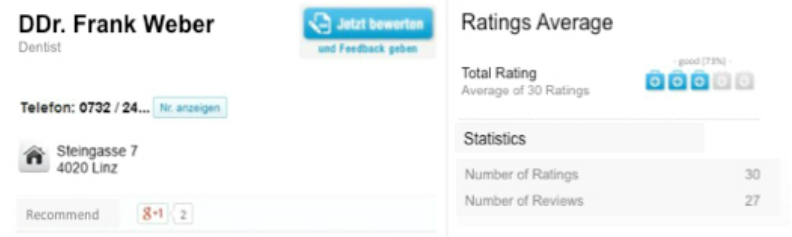
Figure 2. Manipulated rating card for the high-number/emotional review condition.